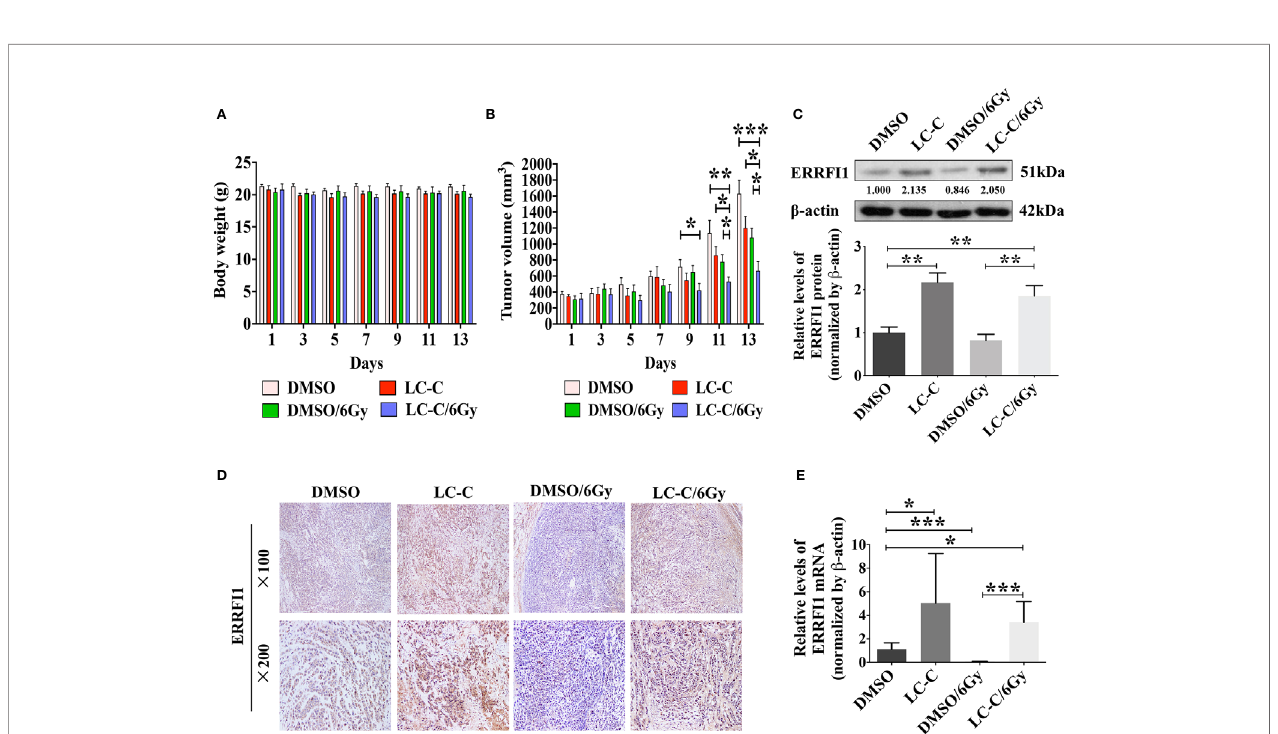
FIGURE 7 | LC-C induces radiosensitivity in xenograft models. A549-IR xenograft nude mice were treated with LC-C, radiation, or both. (A) Body weight of mice in four groups; (B) Graphs showing the tumor growth of A549-IR xenograft; (C) Western blotting showing change of expressions of ERRFI1 in xenograft tumors; (D) Immunohistochemical staining of ERRFI1 in xenograft tumors; (E) qRT-PCR analysis of ERRFI1 expression in xenograft tumors. Samples were run in triplicate and normalized to b -actin mRNA to determine relative expression. One datum that deviated noticeably from the group was eliminated. Results shown are the means ± standard deviation. *Signi fi cant difference at P < 0.05 level. **Signi fi cant difference at P < 0.01 level. ***Signi fi cant difference at P < 0.001